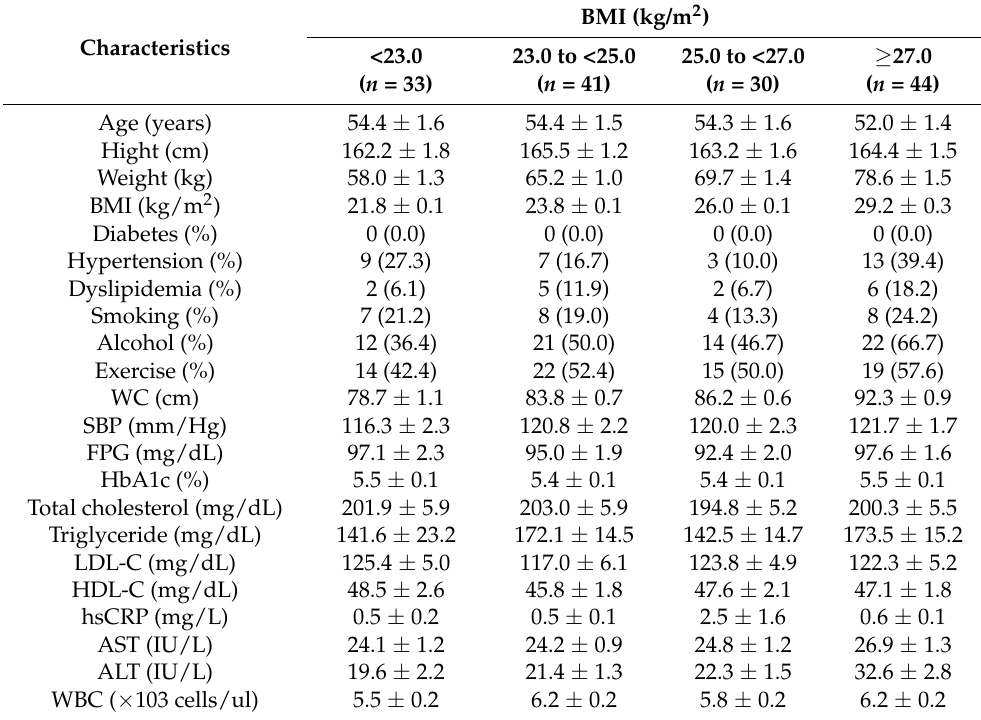
Table 1. Baseline characteristics of the human subjects by BMI.